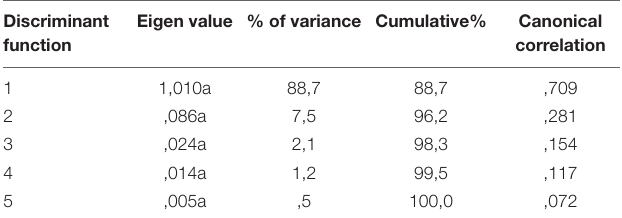
TABLE 5 | Classification model confusion matrix (% of true and false classification results in the control sample data). Discriminant Eigen value % of variance Cumulative% Canonical function